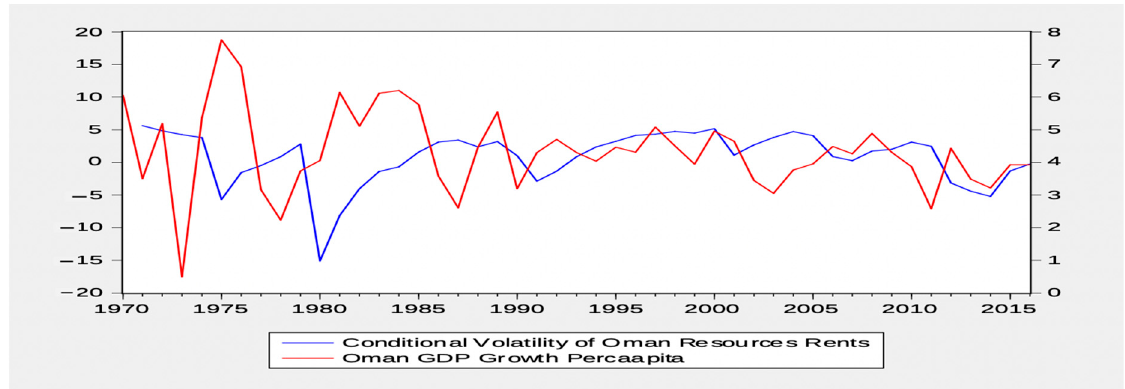
Figure A2. Conditional volatility of Oman.